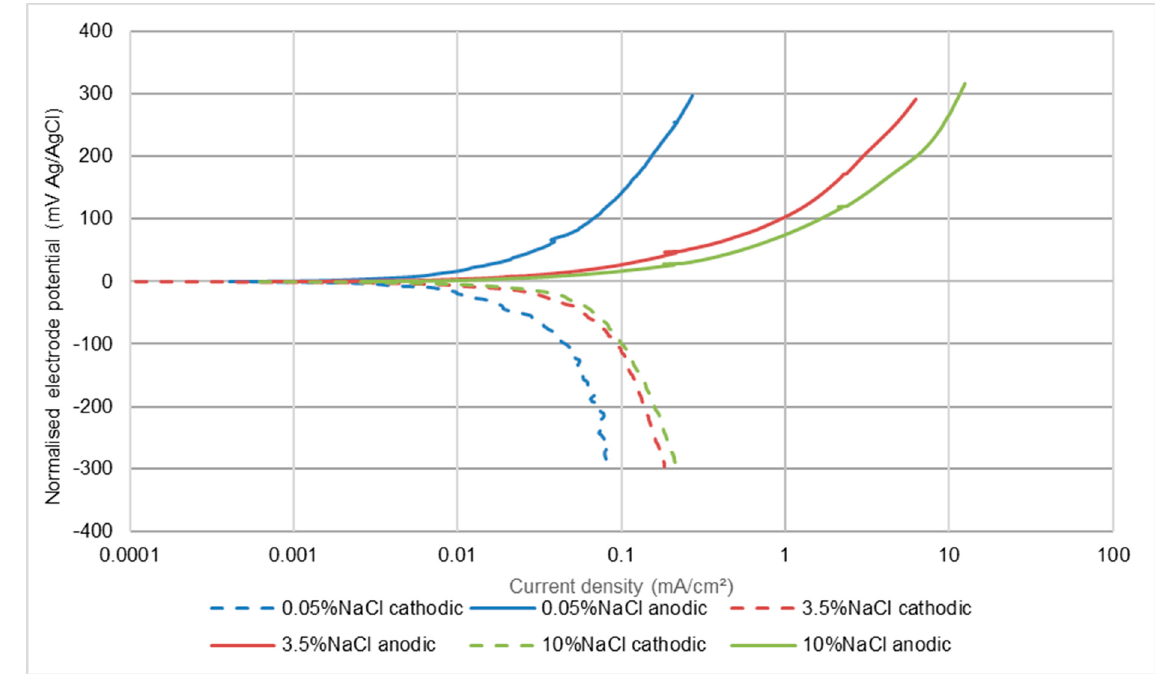
Figure 9. Polarisation plots for UNS G43400 steel in quiescent conditions.